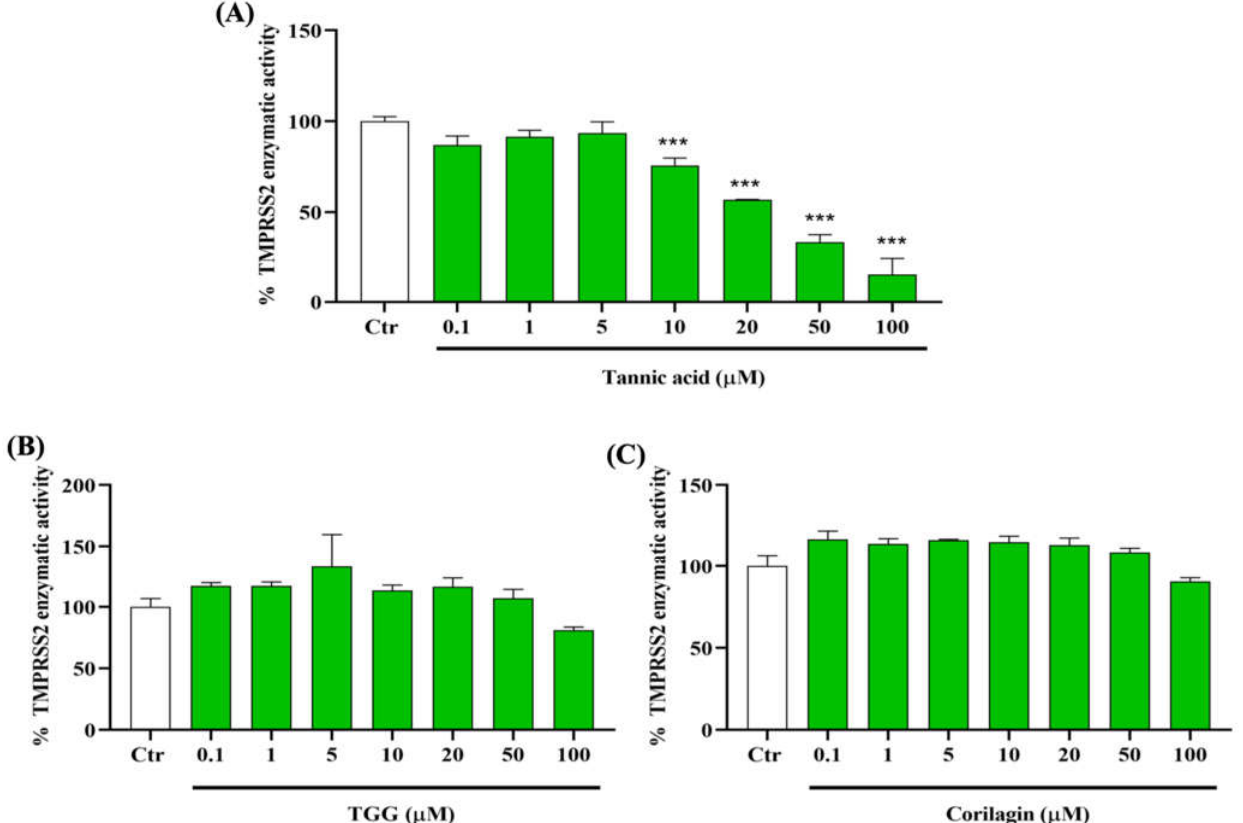
Figure 3. Inhibitory effects of TA, TGG, and corilagin on human transmembrane protease serine 2 (TMPRSS2) activity. The effects of different concentrations (0.1 to 100 µ M) of ( A ) TA, ( B ) TGG, and ( C ) corilagin are tested on the activity of TMPRSS2. The fluorescence units in control conditions are considered as 100%. Blank values are subtracted from all the readings before the conversion into percentage of activity. Results are expressed as mean ± SD (n = 3). Statistical analysis is performed using one-way ANOVA followed by Tukey post hoc test with *** p < 0.001 compared to positive control wells.